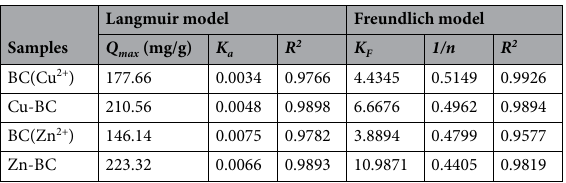
Table 7. Isotherms parameters for the adsorption of heavy metal ions.